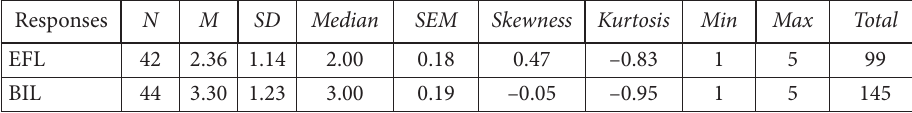
Table 1. Descriptive statistics of the scale items A – originality of the idea for English as foreign lan- guage (EFL) and bilingual (BIL) groups (source: created by